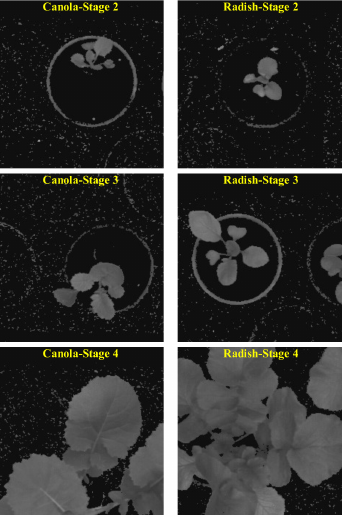
Figure 3. Canola and radish plants at di ff erent growth stages in the “bccr-segset” dataset.